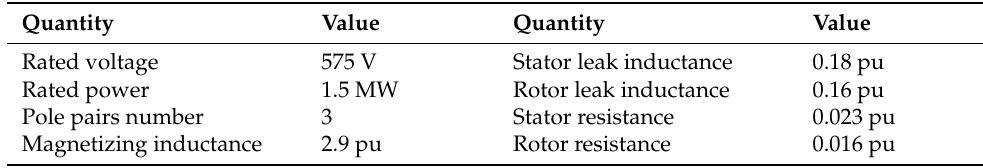
Table 3. Main parameters of the simulated converter